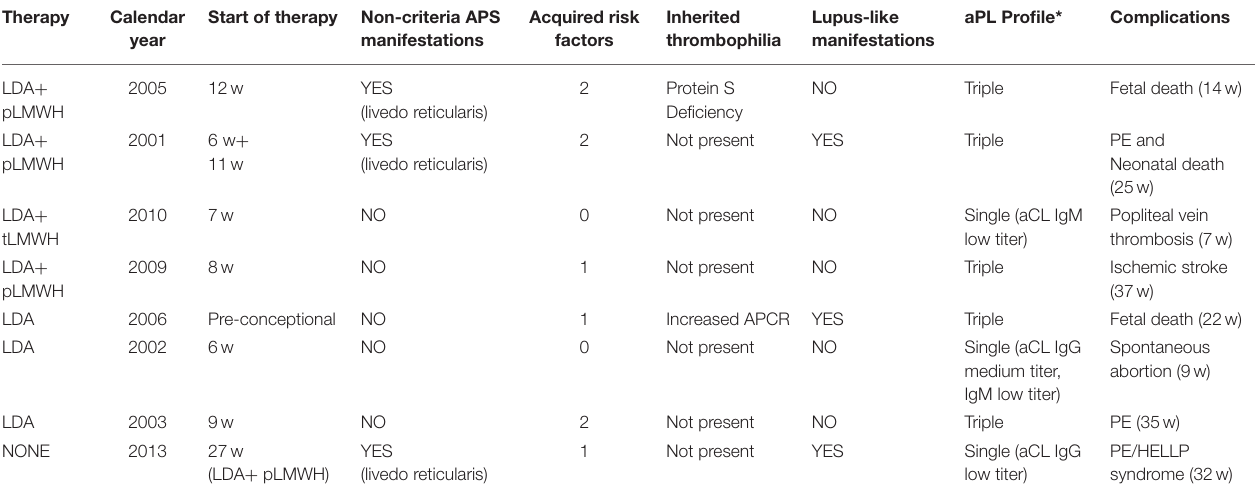
TABLE 1 | Description of the 8 complicated pregnancies.